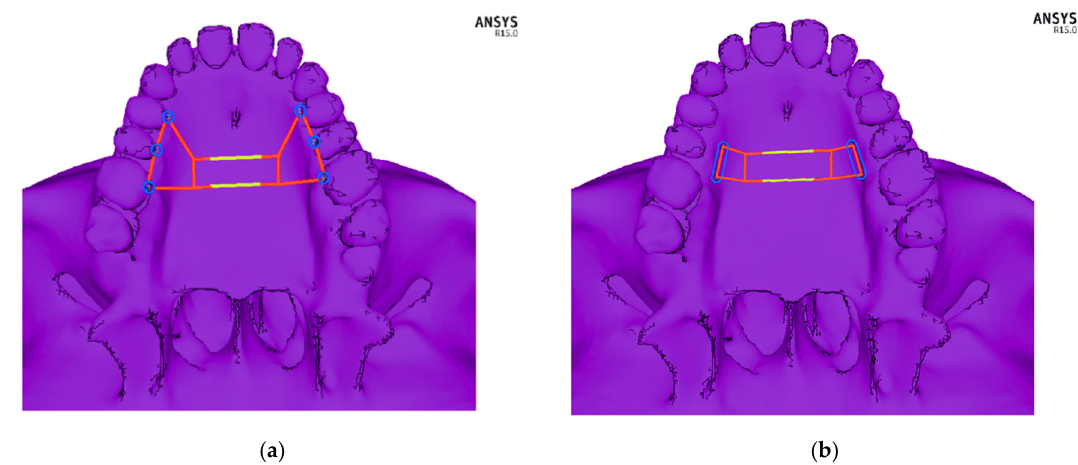
Figure 2. Schematic picture of the designed orthodontic devices: ( a ) fixed to the bone—bone-borne type, and ( b ) fixed onto teeth—tooth-borne type. The module that was expanded by 0.5 mm is marked in yellow.